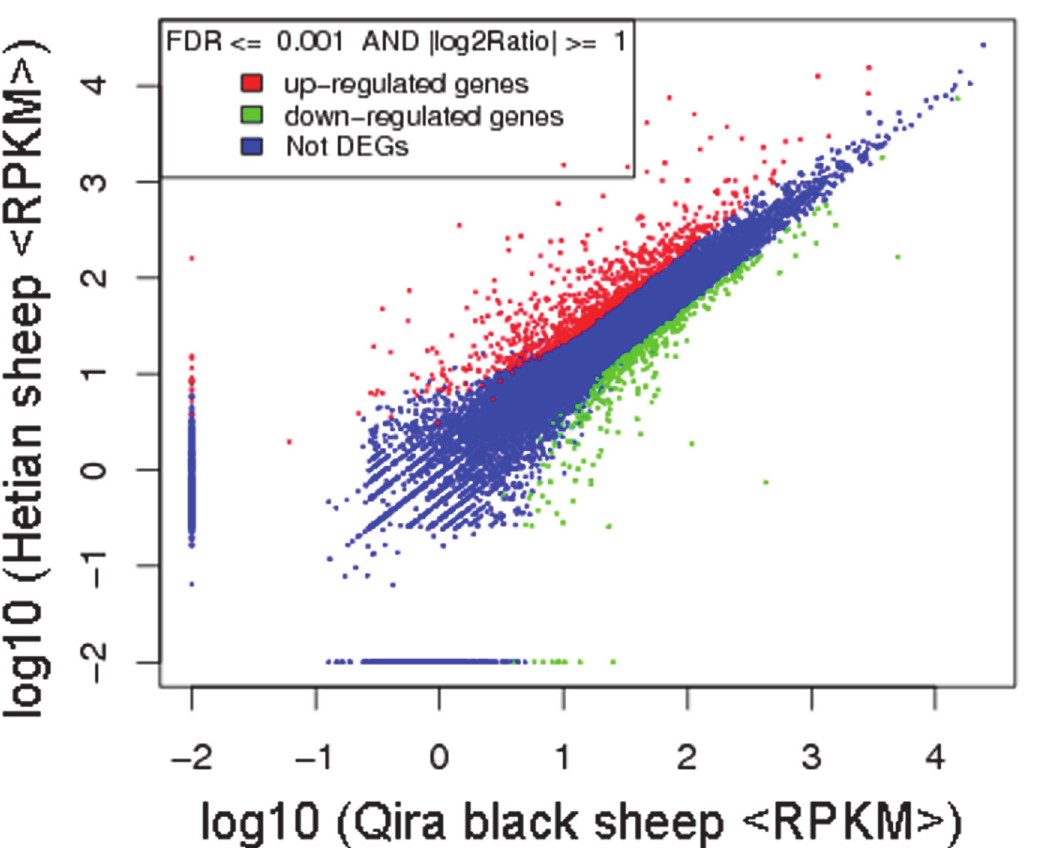
Fig 3. Comparison of gene expression levels between the two libraries. The expression levels are estimated by RPKM value.